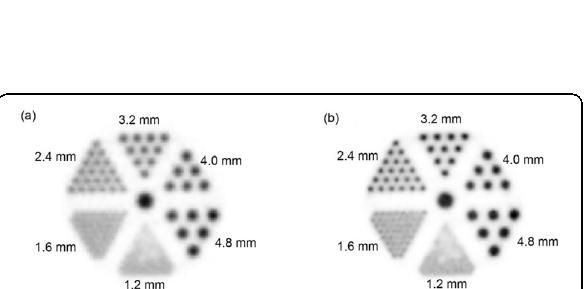
Fig. 2 (abstract A32). Fully-3D Image reconstruction of a Derenzo phantom scanned on the mini-EXPLORER-II without and with our resolution model. (a) Single-ray tracing projector w/o PSF modeling; (b) Pre-calculated system matrix w/multiple-ray tracing projector PSF modeling. The 1.6 mm hot rods can be resolved using our accurate system matrix modeling with the 2.85x2.85x18.1 mm 3